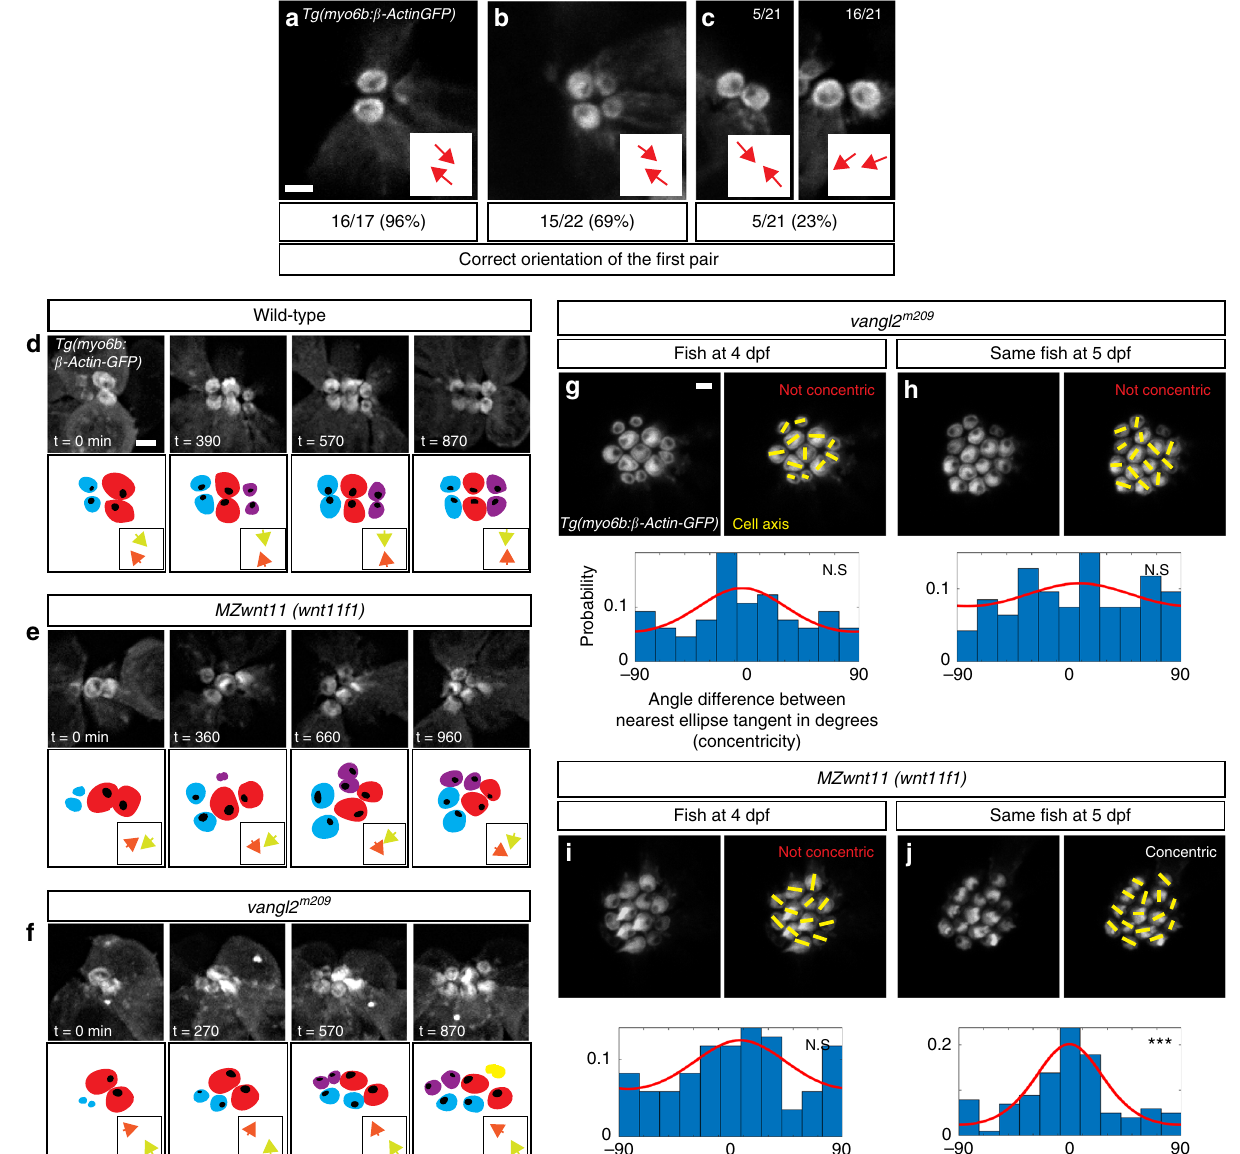
Fig. 4 Differences in the appearance of the hair cell phenotypes in vangl2 and MZwnt11 (wnt11f1) mutants. a – c Orientation of the fi rst pair of hair cells in primII-derived neuromasts of wild type ( a ), MZwnt11 (wnt11f1) mutants ( b ), and vangl2 mutants ( c ) labeled with Tg(myo6b: β -Actin-GFP) . In c , the left panel shows the number of correctly oriented pairs, and the right panel shows the number of incorrectly oriented pairs (the majority). The percentages for each of the conditions represent the number of pairs that show correct hair cell orientation. d – f Hair cell orientation over time in wild type ( n = 3 animals) ( d ), MZwnt11 (wnt11f1) mutants ( n = 5) ( e ), and vangl2 mutants ( n = 2) ( f ) labeled with Tg(myo6b: β -Actin-GFP) . Each of the conditions is depicted using a color- coded cartoon, and the hair cell orientation of the fi rst pair is represented by arrows in the box on the lower right. To differentiate between each hair cell of the pair, each of the arrows is in a different color. g – j Hair cell orientation of the same vangl2 mutant fi sh at 4 dpf ( g ) and 5 dpf ( h ), and the same MZwnt11 (wnt11f1) mutant embryo at 4 dpf ( i ) and 5 dpf ( j ) in a Tg(myo6b: β -Actin-GFP) transgenic background. The distribution of angles of each given hair cell with respect to the nearest ellipse tangent (concentricity) for primII-derived neuromasts of all the conditions tested is shown. Note that only the MZwnt11 (wnt11f1) mutants at 5 dpf ( j ) show signi fi cant concentricity (Uniform distribution p -values in g = 0.223, h = 0.469, i = 0.308, j = 1.97 × 10 − 07 ). The von Mises distribution is shown for visual display of the data distribution. Yellow lines represent the polarity axis for each hair cell. “ Not Concentric ” vs. “ Concentric ” labels in g – j were based on the statistical signi fi cance ( n = 8 neuromasts for each condition). Scale bars in a, d , and g equal 2 μ wild-type atoh1a CRISPants show no hair cells (Fig. 5o, p). In of support cell orientation observed in primII neuromasts of Wnt atoh1a CRISPants support cells are still normally aligned (Fig. 5o, pathway genes is not a consequence of the hair cell misorienta- p). Thus, support cell alignment is independently regulated from tion. Altogether, these results indicate that, while vangl2 and scrib hair cells. Furthermore, MZwnt11 (wnt11f1) mutants injected are not required for support cell alignment, the Wnt pathway with atoh1a CRISPR still show loss of support cell alignment in genes are essential for the proper coordinated organization of primII-derived neuromasts (Fig. 5q, r). Thus, the disorganization support cells in primII-derived neuromasts.